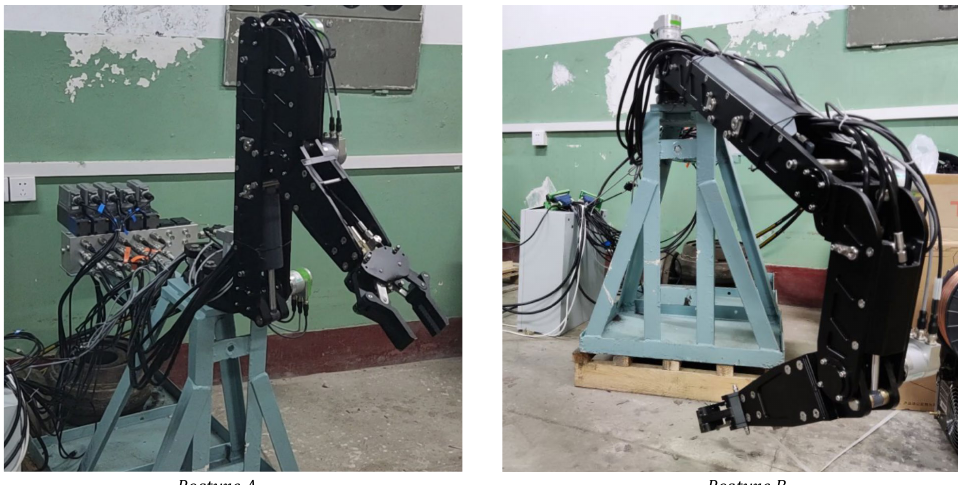
𝑃𝑃𝐽𝐽𝑓𝑓𝐿𝐿𝑃𝑃𝑒𝑒𝑖𝑖 𝐵𝐵 Figure 3. Two postures of the manipulator in the experiments.